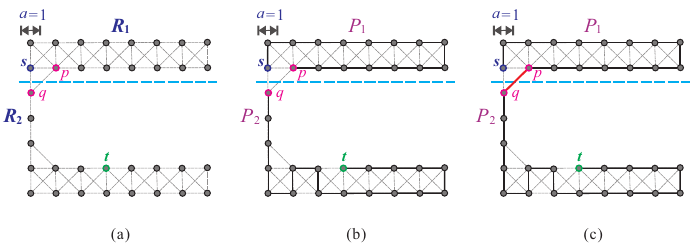
Figure 12. ( a ) A horizontal separation on C ( m , n ; k , l ; c , d ) , ( b ) Hamiltonian paths P 1 and P 2 in ( R 1 , s , p ) and ( R 2 , q , t ) , respectively, and ( c ) a Hamiltonian ( s , t ) -path in C ( m , n ; k , l ; c , d ) , where a = 1 and bold lines indicate the constructed Hamiltonian